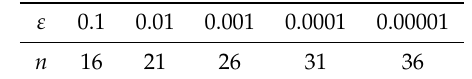
Table 16. Number n of iterations needed by the a priori estimate if started with x = ( 19.27,19.27 ) , y = ( 19.36,19.36 ) and p = 2.